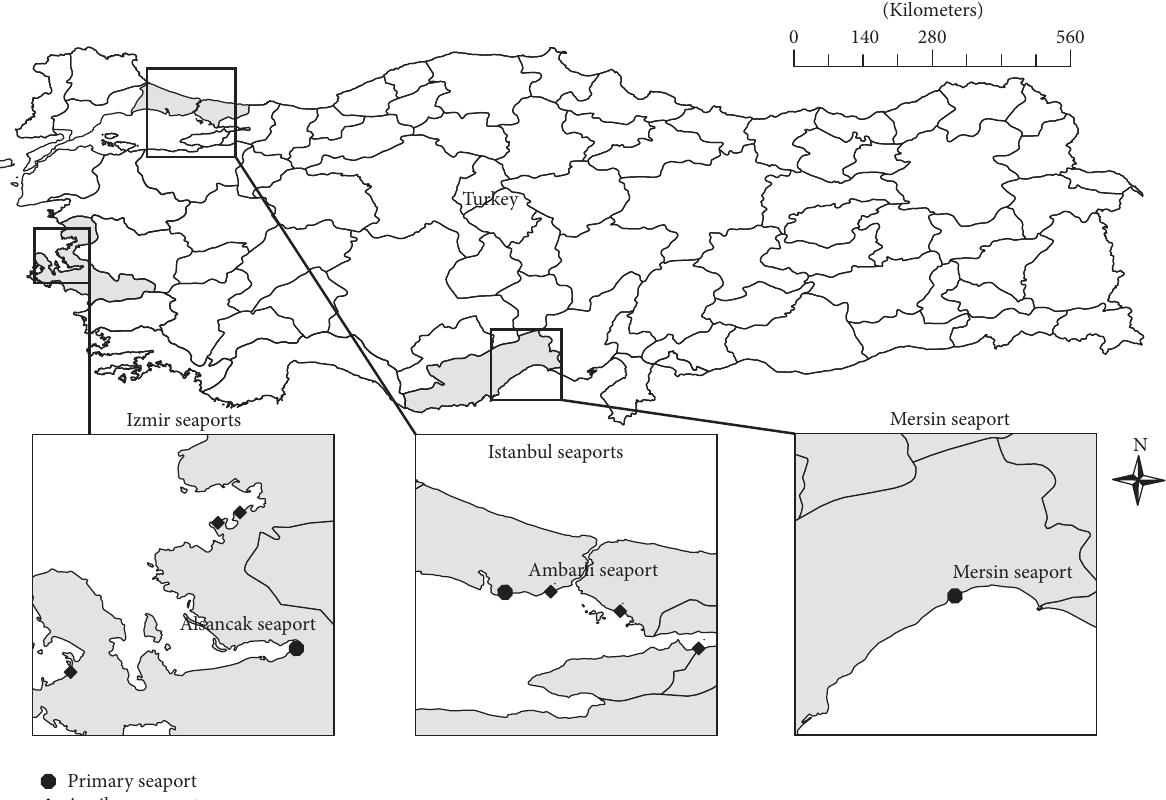
Figure 2: The primary and auxiliary seaports in Turkey which were considered in this